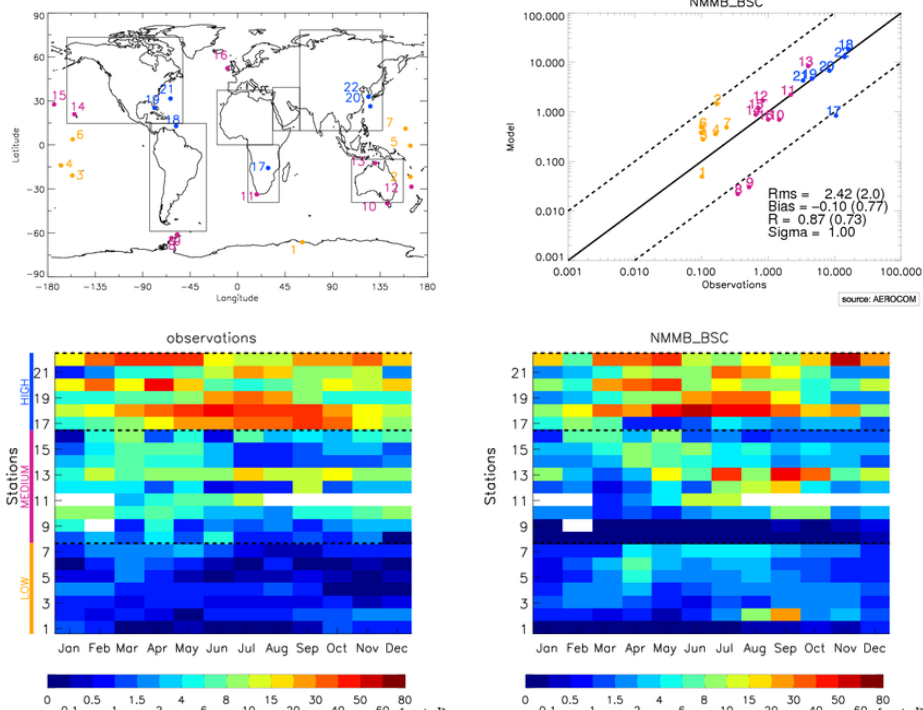
Fig. 9. Network of stations measuring surface concentration in the upper left panel. Names and locations for each selected station are given in Huneeus et al. (2011). In the upper right panel, yearly averaged measured surface concentration versus modeled one at each station in µgm − 3 . It includes the root mean square error (RMS), bias, ratio of modeled and observed standard deviation ( σ ) and correlation ( R ). Normalized mean bias and normalized root mean square error are given in parenthesis next to RMS and mean bias, respectively. The logarithmic correlation is given in parenthesis next to R . Black continues line is the 1:1 line whereas the black dotted lines correspond to the 10:1 and 1:10 lines. Bottom panels show monthly averages of measured (left) and simulated (right) surface concentration. Each row corresponds to the seasonal cycle at one of the stations. White color corresponds to month without measurements.